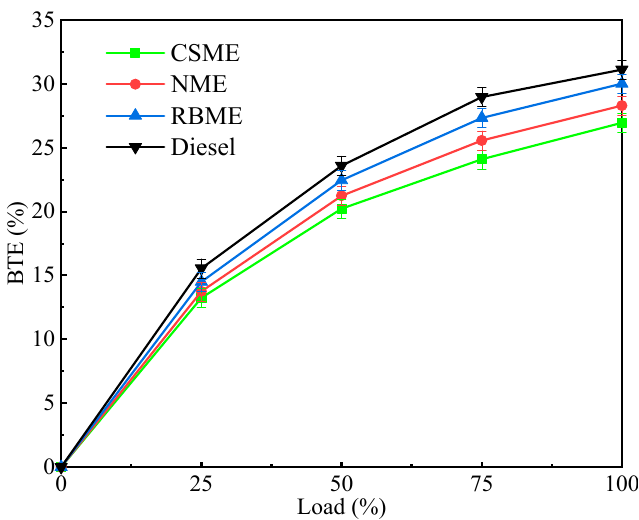
Figure 15. BTE comparison of three different biodiesel and diesel under different loads [183].